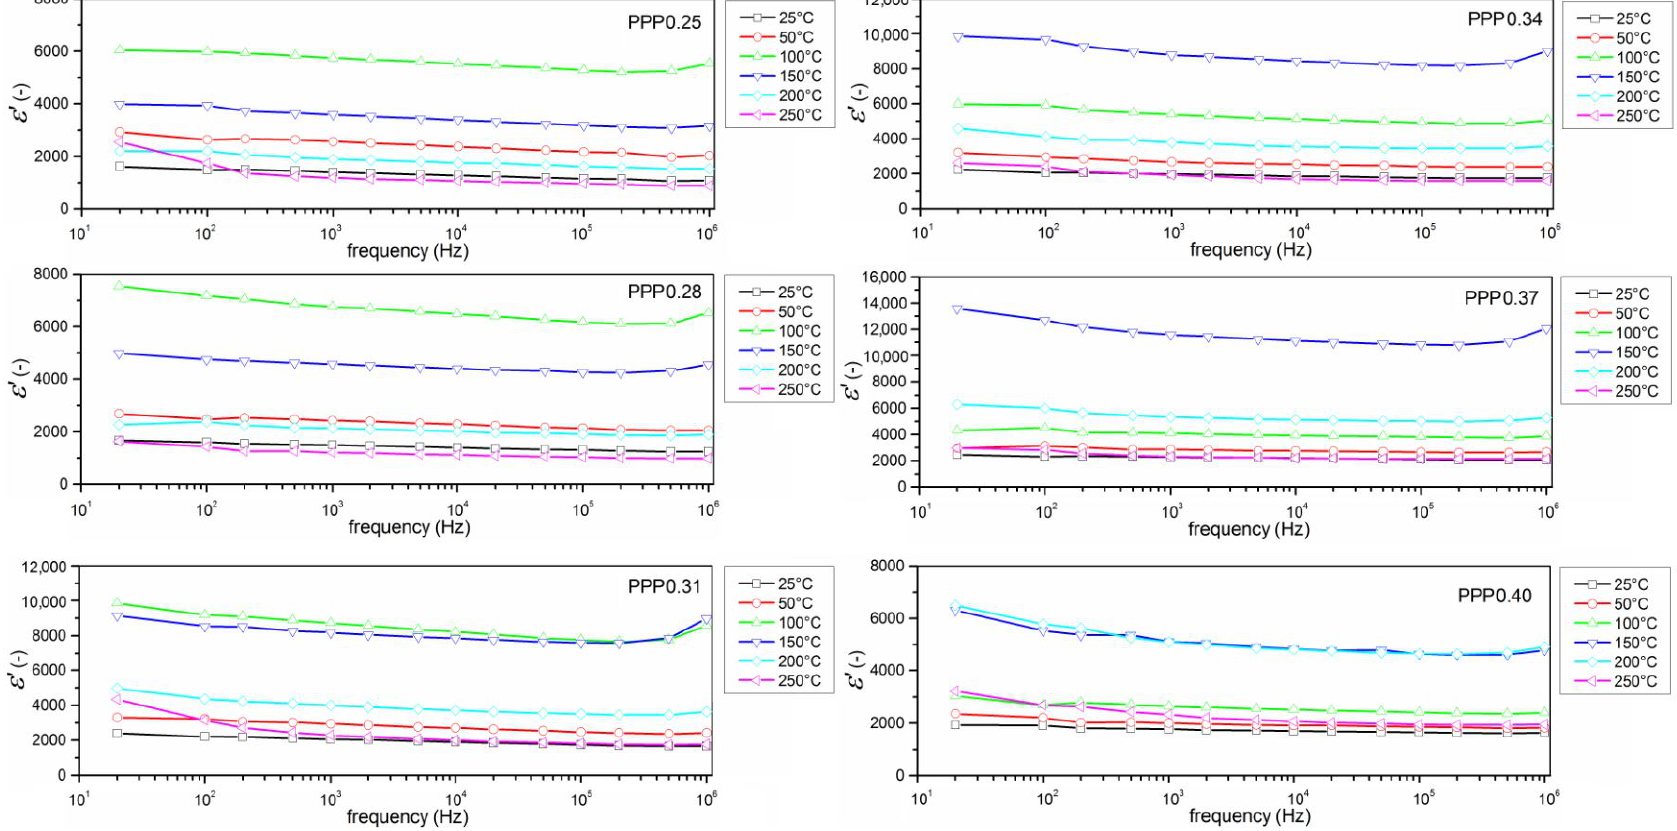
Figure 6. Frequency dependence of the real part of dielectric permittivity for PMN–PT–PS ceramics with various x at different